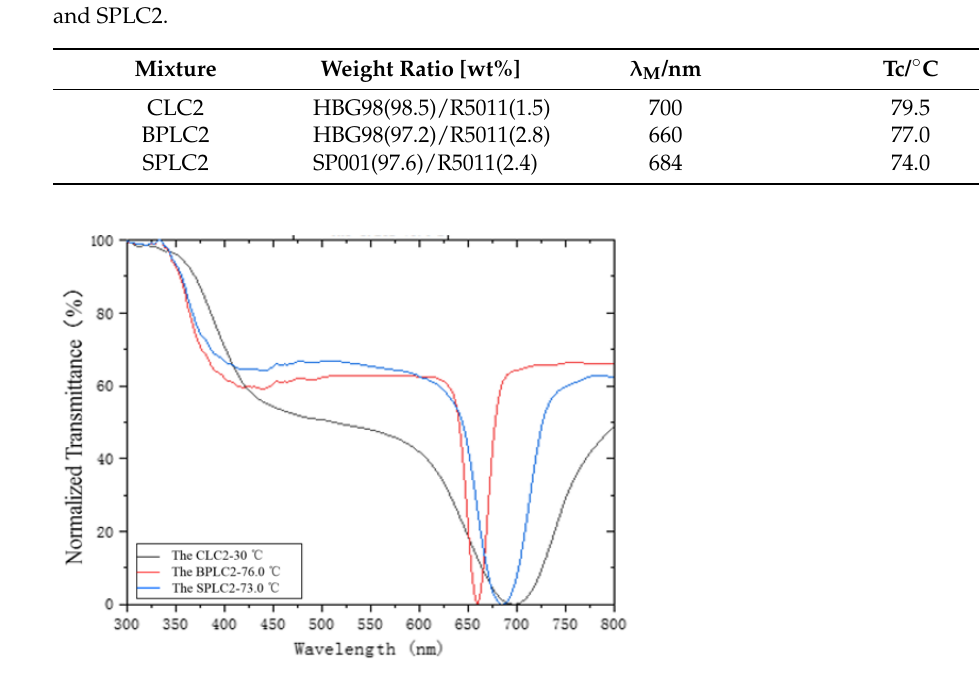
Figure 11. The reflection spectra of CLC2, BPLC2, and